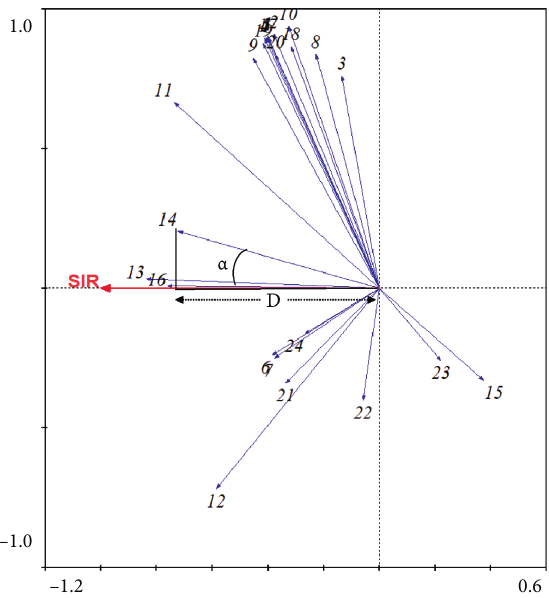
Figure 5: Redundancy analysis of phytochemical components and efficacy